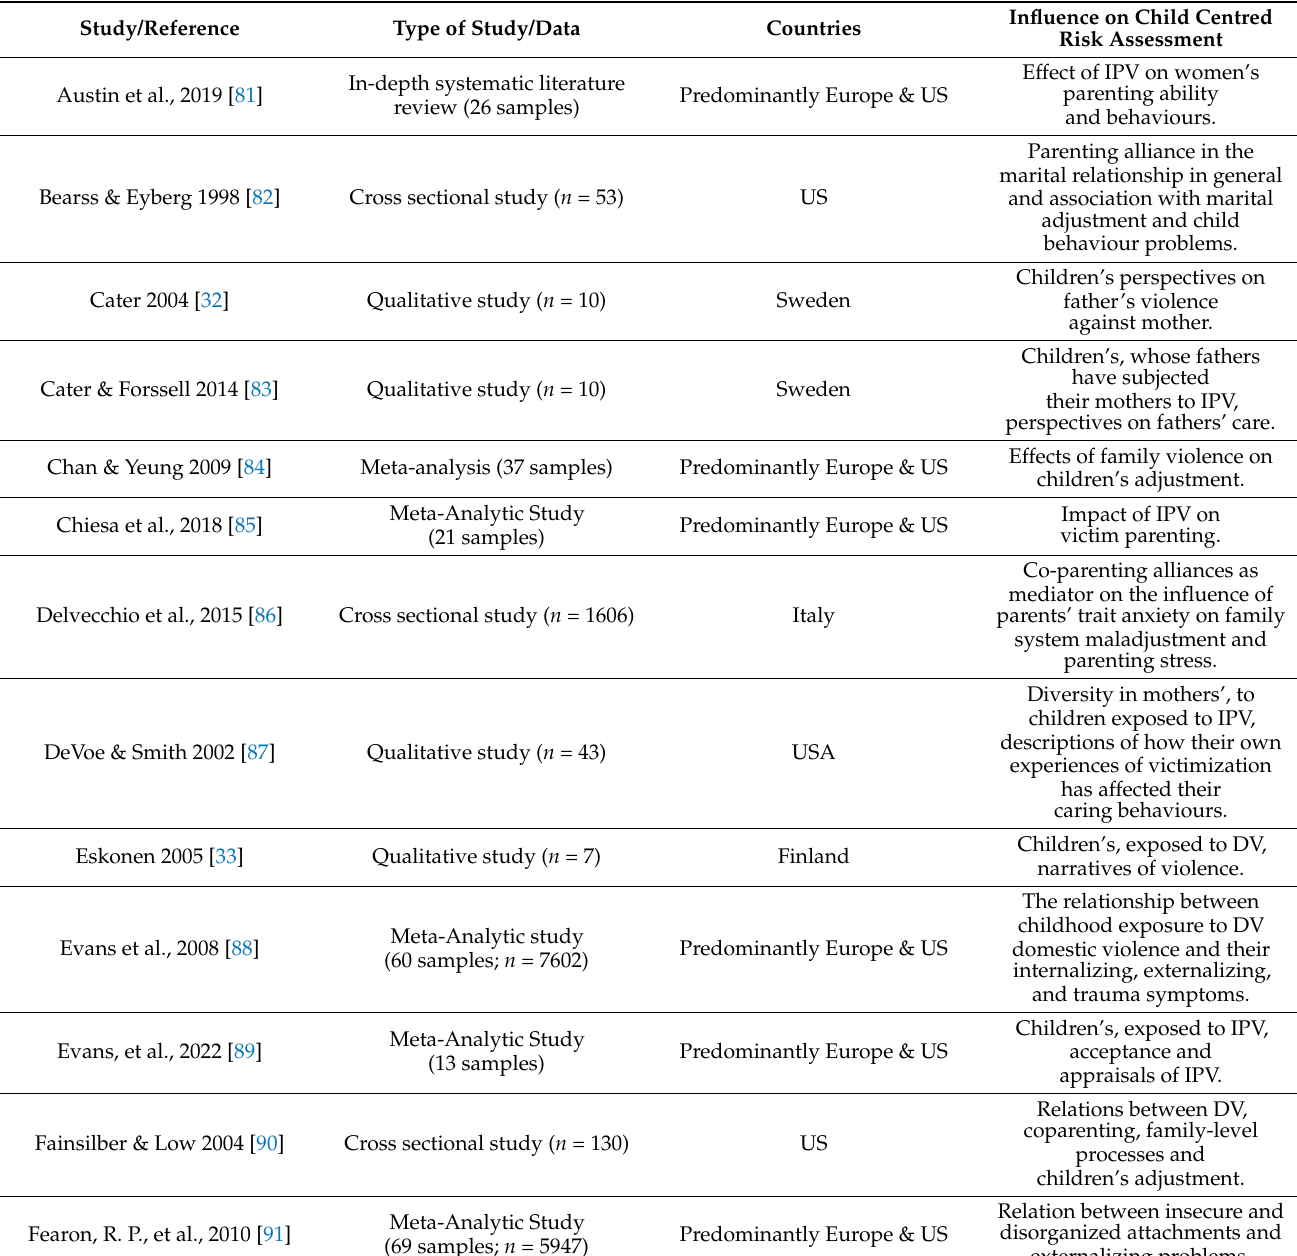
Table 4. Developmental